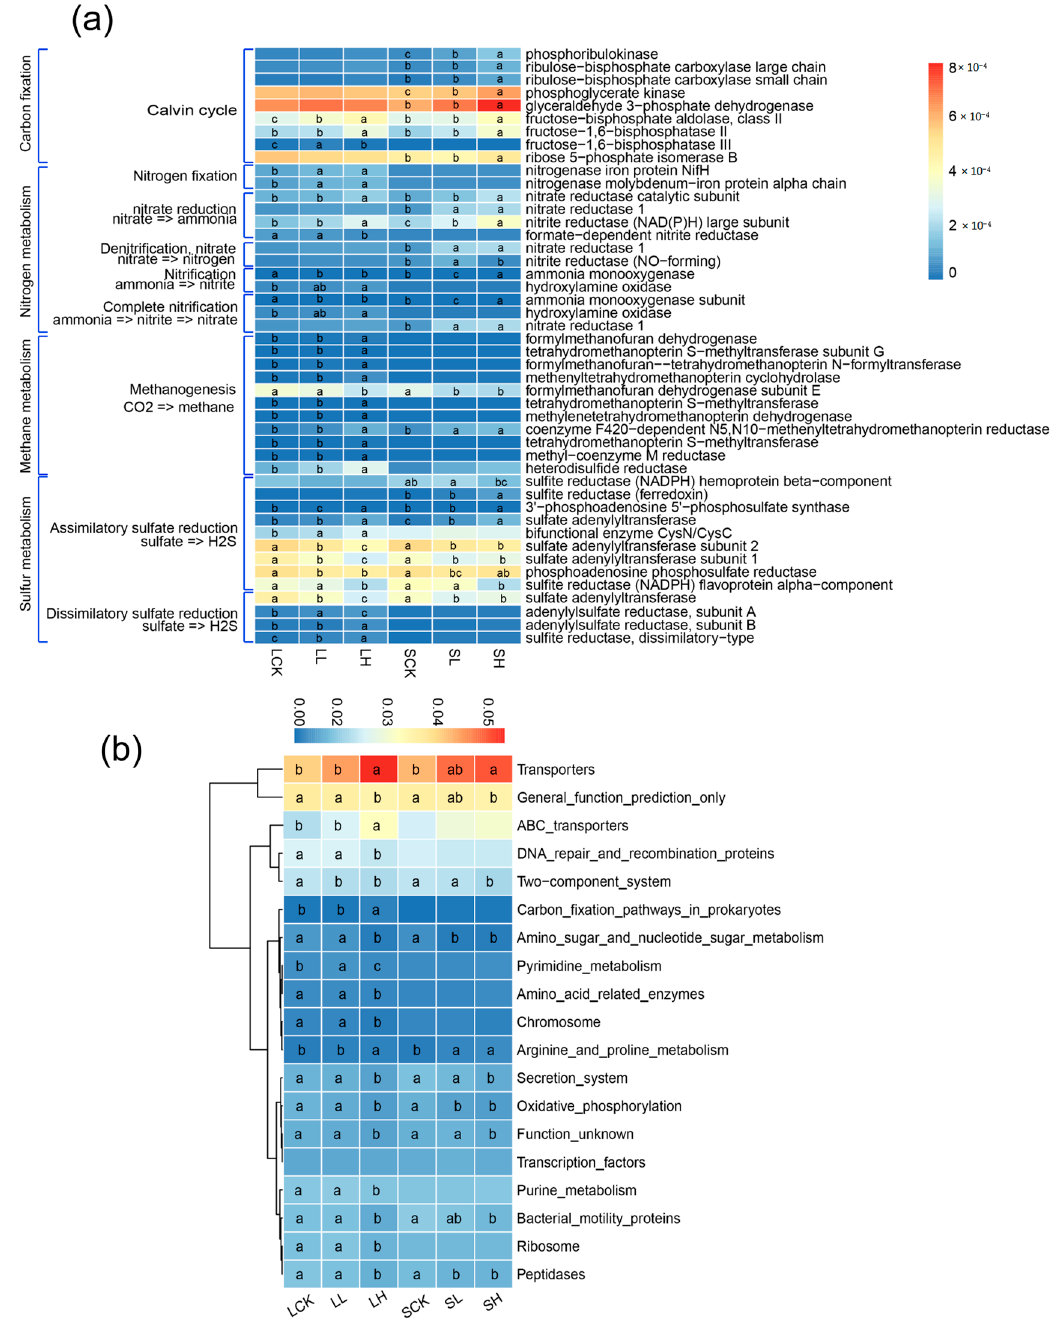
Figure 7. Predicted functions of top 19 of KEGG pathway in different soil treatments. ( a ) Energy metabolic pathways at second level, ( b ) variety of energy metabolic pathways at third level. Different letters to show statistical significant differences by an ANOVA analysis ( p < 0.05, n = 3).